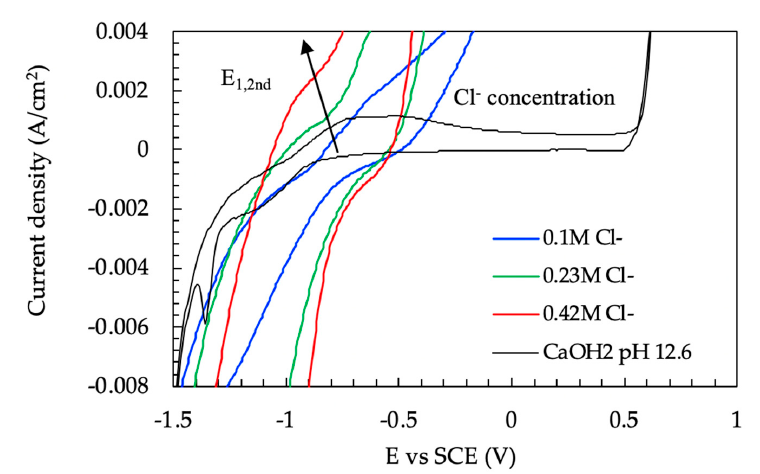
Figure 6. Close-up of Figure 5 in the zone of the increases in the anodic current that evidenced the potential E 1,2nd. potential E 1,2nd.